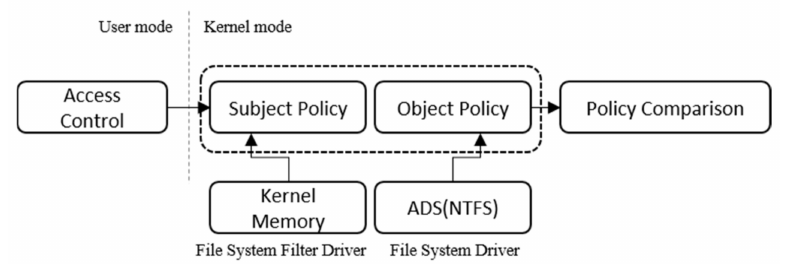
Figure 9. Fetching and comparing the security policies.